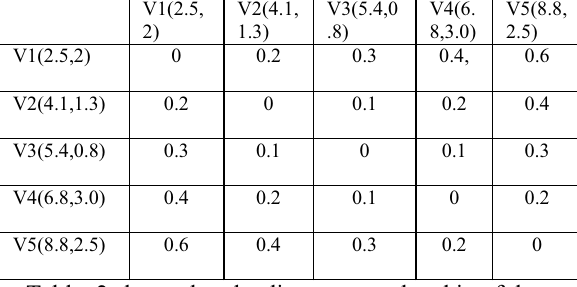
Table: 2 shows that the distance membership of the sensor node